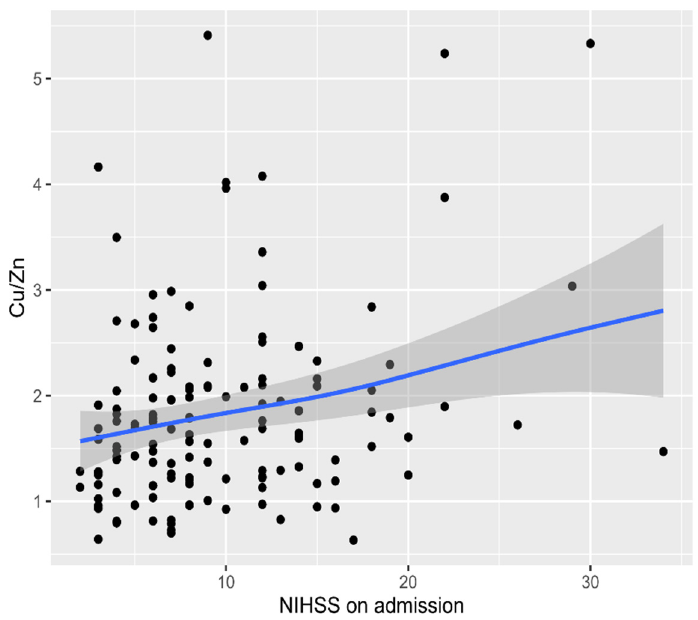
Figure 3. Correlation between the Cu/Zn molar ratios and the National Institutes of Health Stroke Scale (NIHSS) values on admission in patients with acute ischemic stroke (AIS). Abbreviations: Cu, Copper. Zn, Zinc.